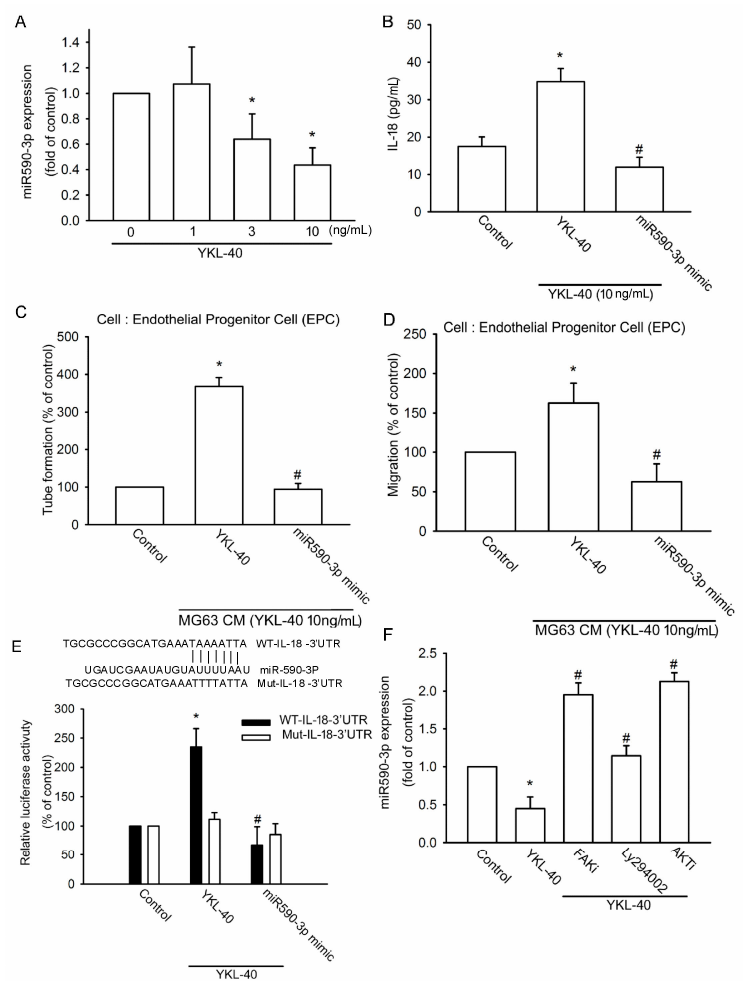
Figure 5. miR-590-3p inhibition regulates YKL-40-induced increases in IL-18 expression. ( A ) MG-63 cells were incubated with YKL-40 for 24 h, and miR-590-3p expression was examined by qPCR ( n = 5 per group). ( B ) MG-63 cells were transfected with control miRNA or miR-590-3p mimic for 24 h, then stimulated with YKL-40 for 24 h, and IL-18 production was examined by ELISA ( n = 5 per group). ( C , D ) CM was collected and applied to EPCs. Capillary-like structure formation and cell migration of EPCs was examined by tube formation and Transwell assay ( n = 4 per group). ( E ) MG-63 cells were transfected with the indicated luciferase plasmids for 24 h and stimulated with YKL-40 for 24 h. Luciferase activity was determined ( n = 4 per group). ( F ) MG-63 cells were pretreated with a FAK inhibitor, LY294002, or an Akt inhibitor for 30 min then stimulated with YKL-40 for 24 h. miR-590-3p expression was examined by qPCR ( n = 5 per group). Results are expressed as the mean ± S.E. * p < 0.05 compared with control. # p < 0.05 compared with the YKL-40-treated group.